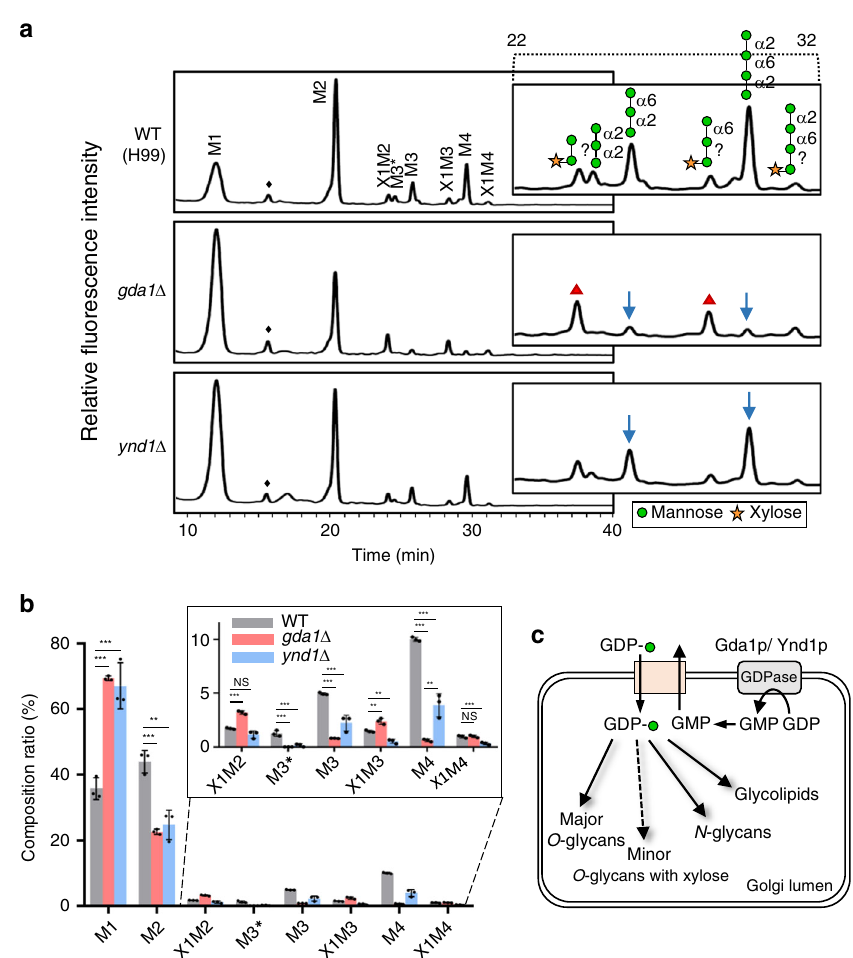
Fig. 6 O -linked glycan pro fi les of C. neoformans gda1 Δ and ynd1 Δ strains. a HPLC pro fi les of O -linked glycans assembled on the cell wall mannoproteins of C. neoformans wild-type (WT), gda1 Δ (YSB4750), and ynd1 Δ (YSB4856) strains. To distinguish small peaks more clearly, HPLC pro fi les from 22 to 32 min in the x - and y -axes were enlarged and inserted. diamond, unknown peak. M mannose, X xylose, M3* α 1,2-mannotriose. Arrow, decreased M3 and M4 peak; triangle, increased O -glycan species containing xylose (X1M2 – X1M4) in the mutant strains. b O -glycan composition of each C. neoformans strain. For quantitative analysis, the area of each peak in the HPLC pro fi le from three independent experiments was measured and presented as percentage of the total area of all peaks. Statistical signi fi cance was calculated by one-way ANOVA analysis with Bonferroni ’ s multiple comparison test. Data are presented as mean values ± standard deviation (SD) (* P < 0.05; ** P < 0.001; *** P < 0.0001). c The proposed function of Gda1p and Ynd1p to provide donor